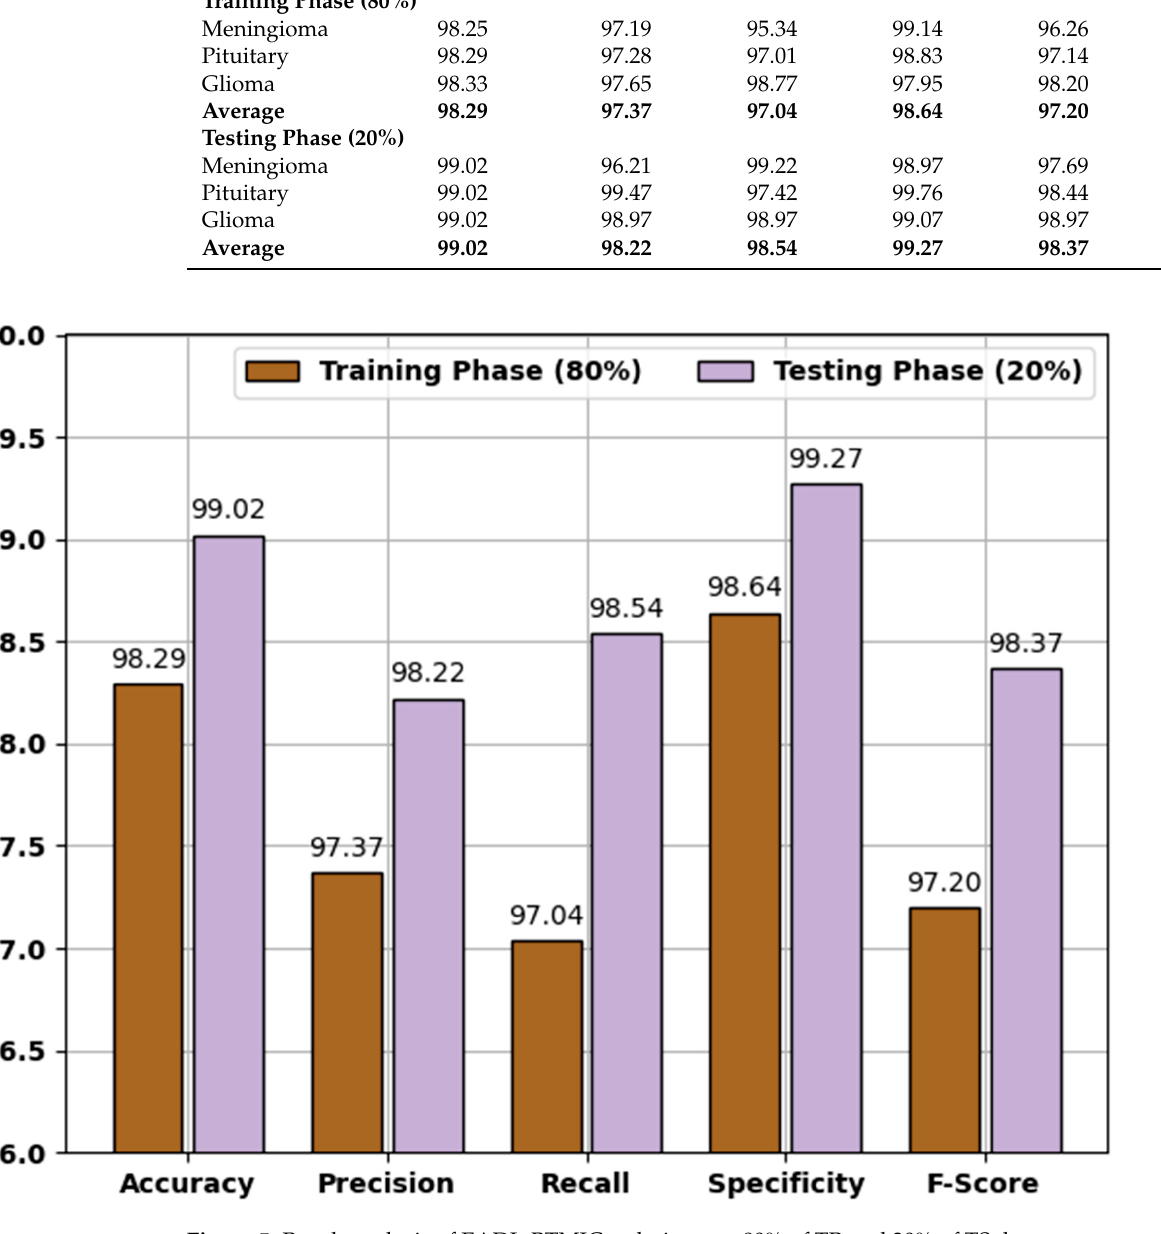
Figure 5. Result analysis of EADL-BTMIC technique on 80% of TR and 20% of TS data. Table 3 and Figure 6 display the overall classifier results of the EADL-BTMIC technique on 70% of TR data and 30% of TS data. The experimental values revealed that the EADL- BTMIC technique illustrated effectual